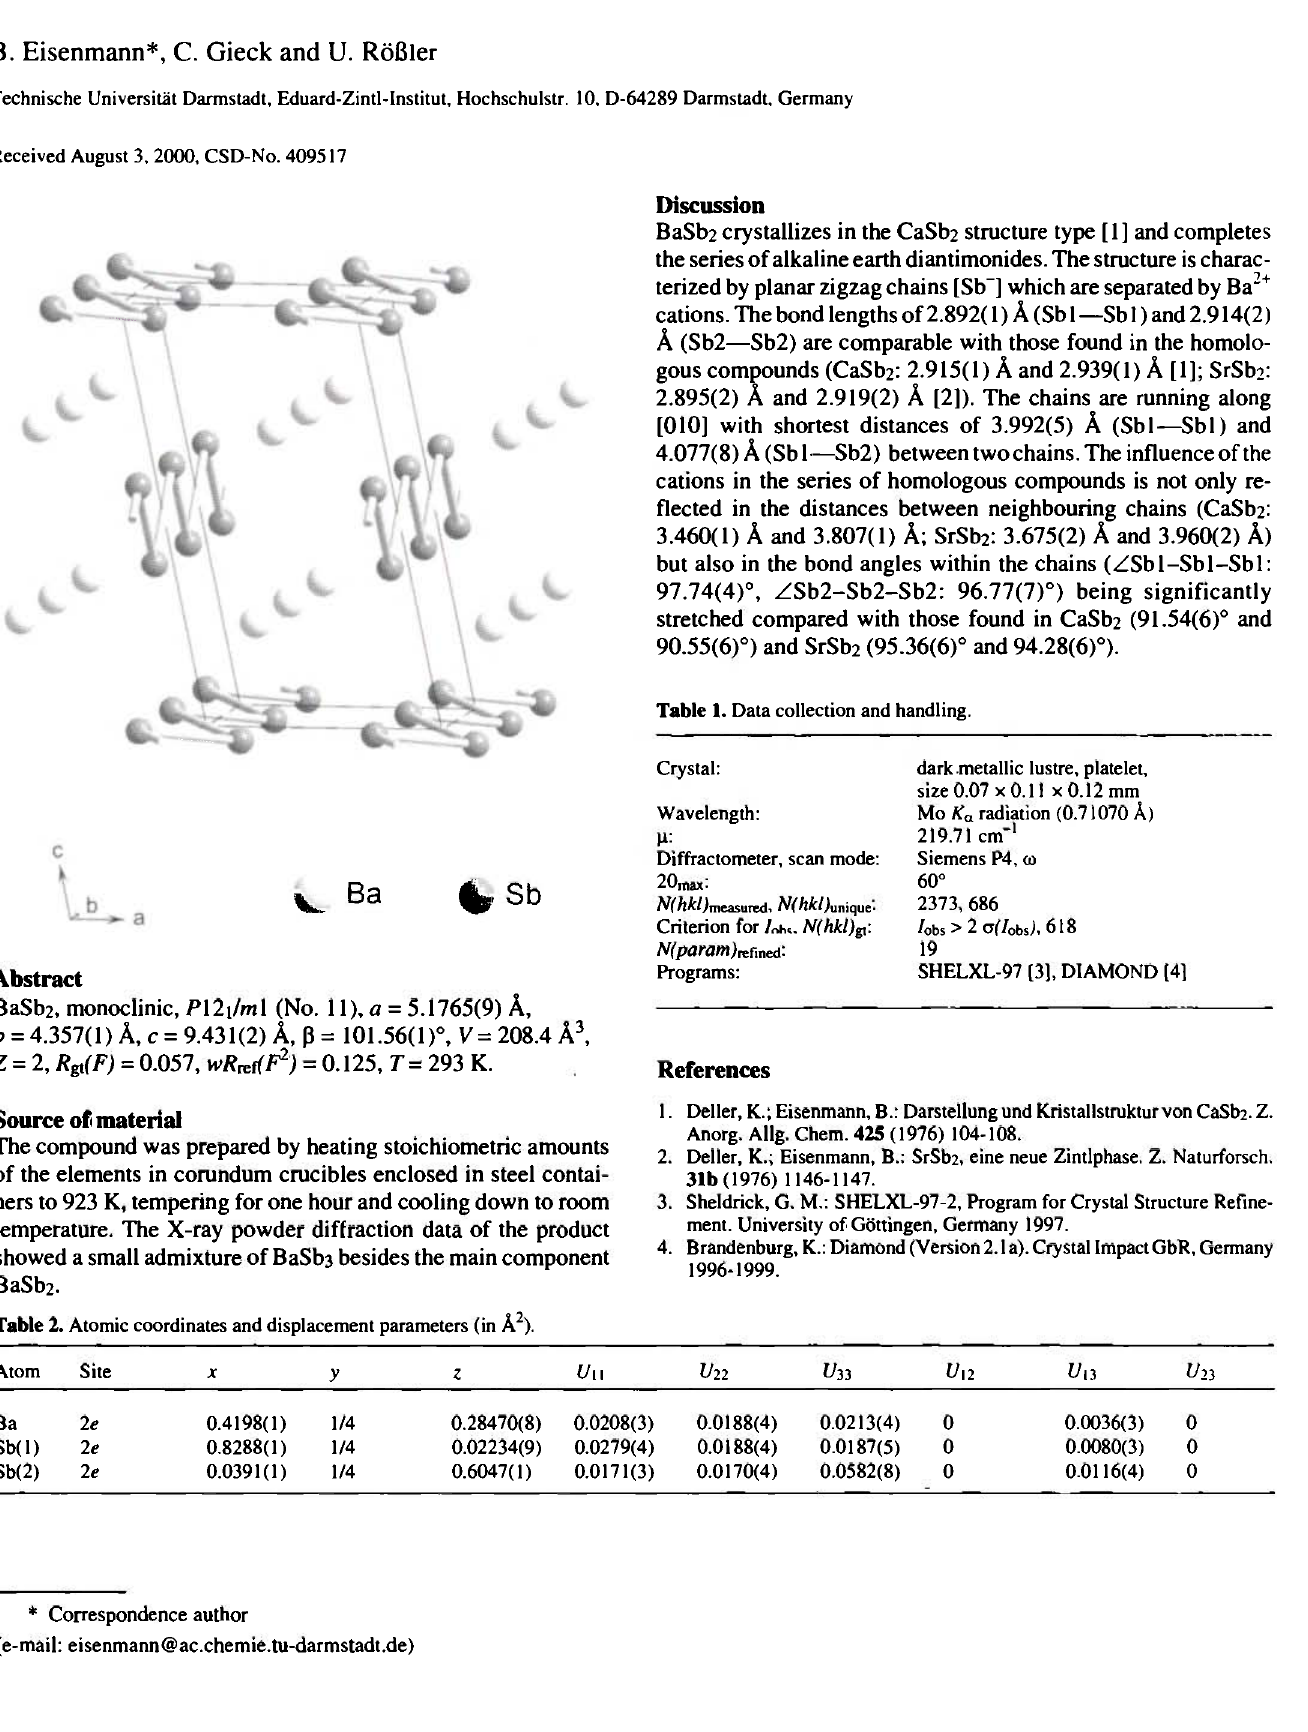
Table 2. Atomic coordinates and displacement parameters (in Ä 2 ).